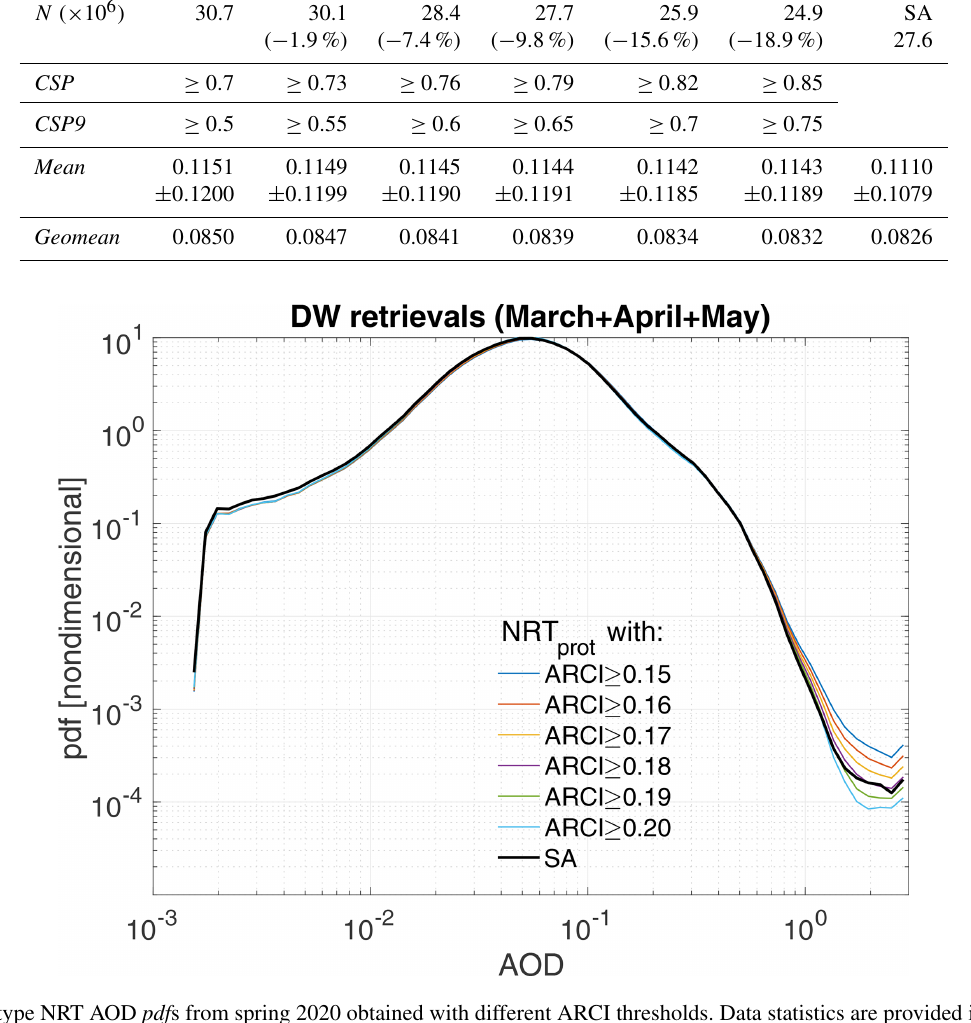
Figure 5. Prototype NRT AOD pdf s from spring 2020 obtained with different ARCI thresholds. Data statistics are provided in Table